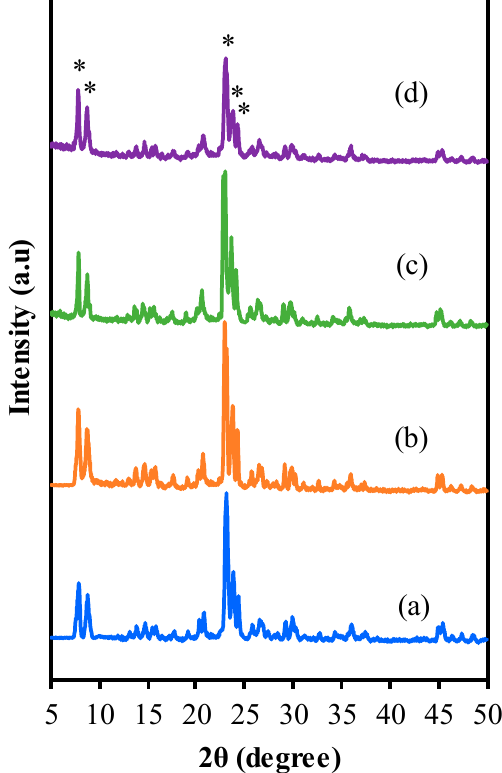
Figure 1. XRD pattern of ( a ) ZSM-5 comm , ( b ) ZSM-5 deAl , ( c ) ZSM-5 deSil ( d ) ZSM-5 deSil-deAl . (*) refer to peaks at 7.96, 8.83, 23.18, 23.99 and 24.45.